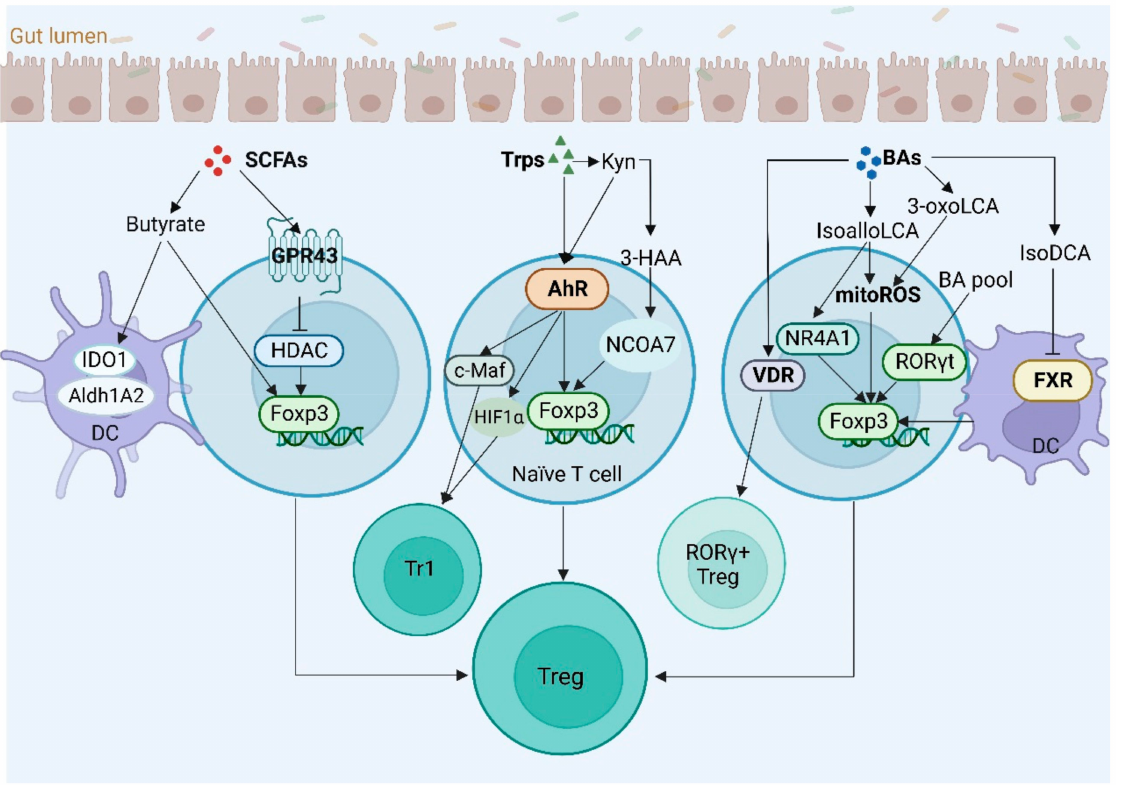
Figure 4. Gut-microbiota-derived metabolites promote differentiation of Treg, Tr1 and ROR γ t + Treg cells. SCFAs, short-chain fatty acids; Trps, tryptophan metabolites; BAs, bile acid metabolites; GPR43, G-protein coupled receptor 43; HDAC, histone deacetylase; Foxp3, forkhead box protein p3; IDO, indoleamine 2,3-dioxygenase 1; Aldh1A2, aldehyde dehydrogenase 1A2; AhR, aryl hydrocarbon receptor; 3-HAA, 3-hydroxyanthranilic acid; Kyn, kynurenine; mitoROS, mitochondrial reactive oxygen species; NR4A1, nuclear receptor subfamily 4, group A, member 1; ROR γ t, retinoid-related orphan receptor- γ t; VDR, vitamin D receptor; FXR, farnesoid X receptor; LCA, lithocholic acid; DCA, deoxycholic acid; DC, dendritic cells; Tr1, type 1 regulatory T